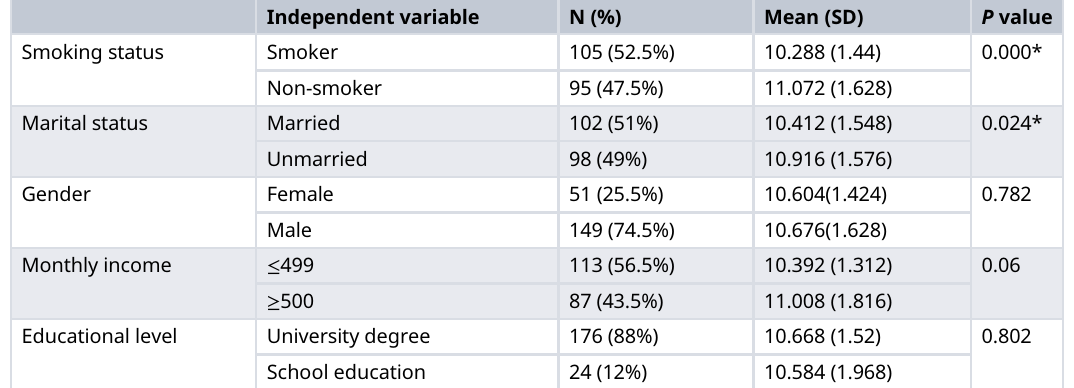
Table 3. Independent t-test result for QoL mean differences based on demographic variables. Independent